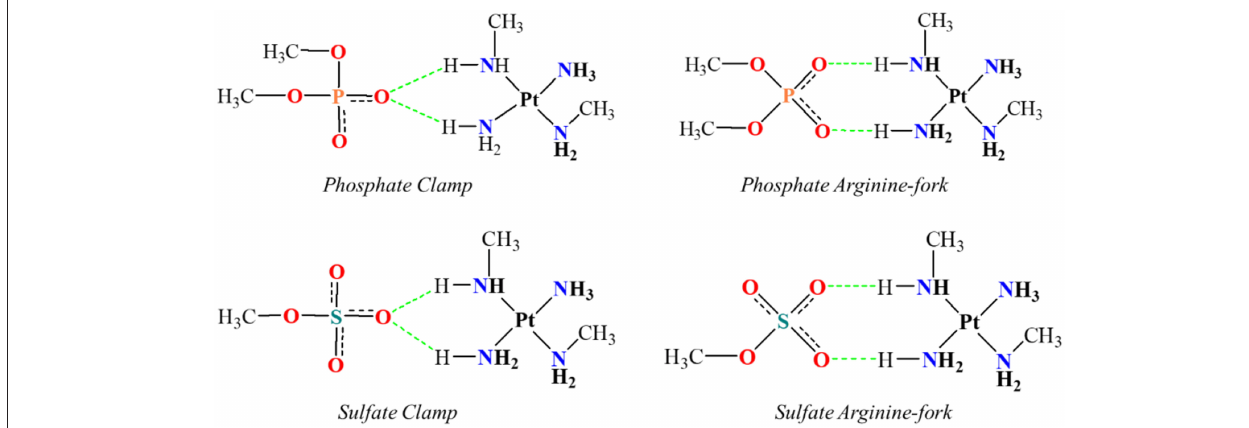
FIGURE 2 | Mimetic models of phosphate and sulfate clamps and arginine-forks.